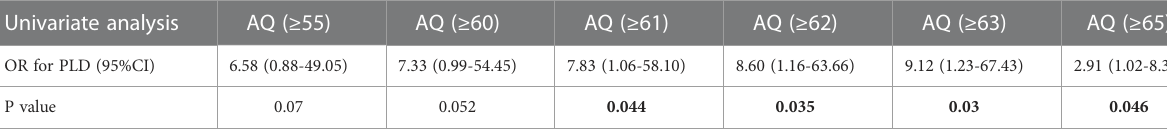
TABLE 8 Optimal AQ threshold in differentiating PLD with no PLD by increments of 1 AQ. Univariate analysis